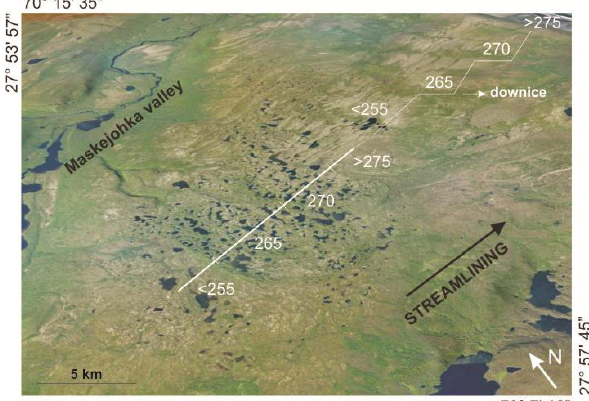
Figure 3. Locations of the electrical-sedimentary measuring sites (1–3) on Maskevarri Ráhppát, Finnmark, northern Norway (Norkart Geoservice AS and Geovekst), and device-specific azimuthal elec- trical conductivity presented for Geonics EM31V (0–6m), EM31H (0–3m), and EM38V (0–1.5m) coil configurations. Numbers A–D refer to photographs shown in Figs. 4 and 5a–c to air photos shown in Fig.